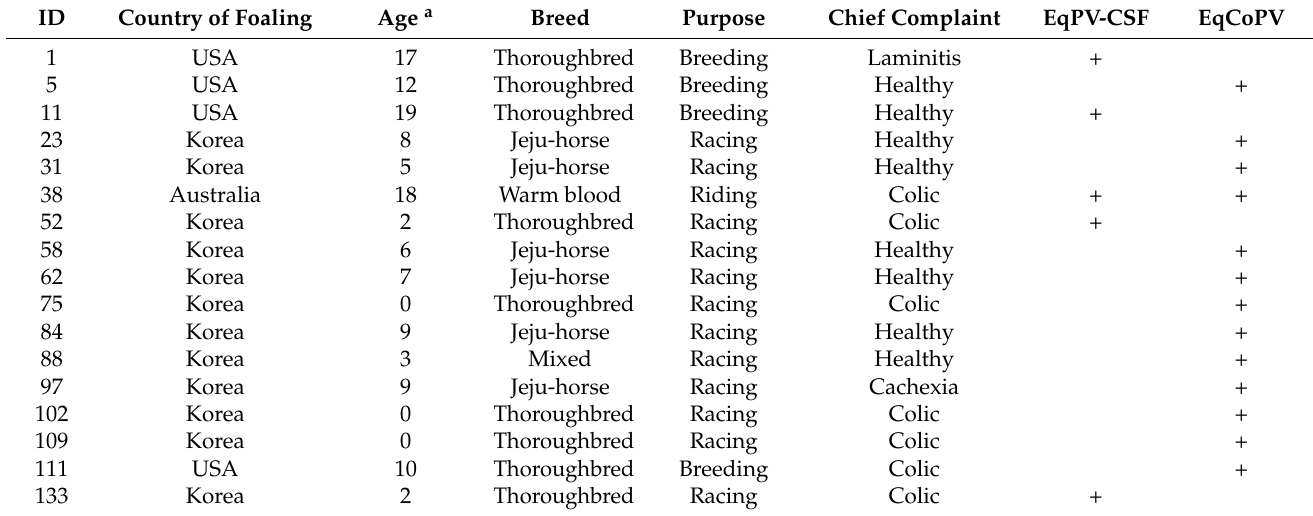
Table 2. Information regarding equine serum samples containing EqPV-CSF and EqCoPV.